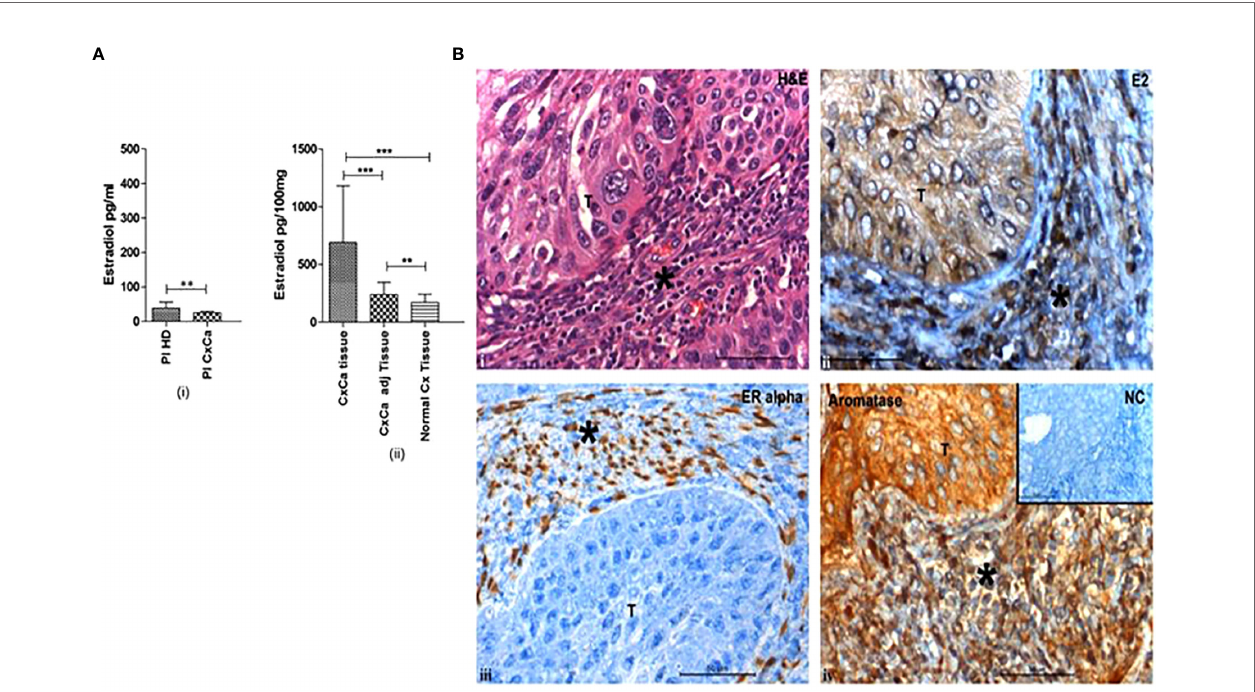
FIGURE 1 | Cervical tumors are enriched in estradiol (E2) and express estrogen receptor a . (A) (i) Concentrations of 17 b -estradiol as determined by ELISA in blood plasma from healthy donors (Pl HD) or patients with CxCa (Pl CxCa) as well as in (ii) tissue samples of cervical tumors (CxCa), areas adjacent to the tumors (CxCa adj), and healthy cervices (Normal Cx). Graph shows mean values ± SEM of n = 30 per group. (B) Staining distribution of 17 b -estradiol, estrogen receptor a , and aromatase in a representative tissue section of SCC cervix. Upper left image (i) shows haematoxylin and eosin staining of a tumour section; upper right image (ii) shows estradiol (E2) staining which was predominantly cytoplasmic in the tumor and both nuclear and cytoplasmic in the stroma and in fi ltrating cells; lower left image (iii) shows the nuclear staining of ER a in the stromal cells only; lower right image (iv) shows aromatase expression detected in the cytoplasm of the tumor, stroma and in fi ltrating cells. Inset: normal rabbit serum negative control. Symbol T indicates tumor location in each picture; * indicates stroma. Images are representative of n = 30. (reproduced from: Adurthi et al, Sci Rep. 2017 Dec 11;7(1):17289. doi: 10.1038/s41598-017- 17102-w. https://pubmed.ncbi.nlm.nih.gov/29229929/#&gid= article- fi gures&pid= fi gure-1-uid-0). **P < 0.01, ***P <